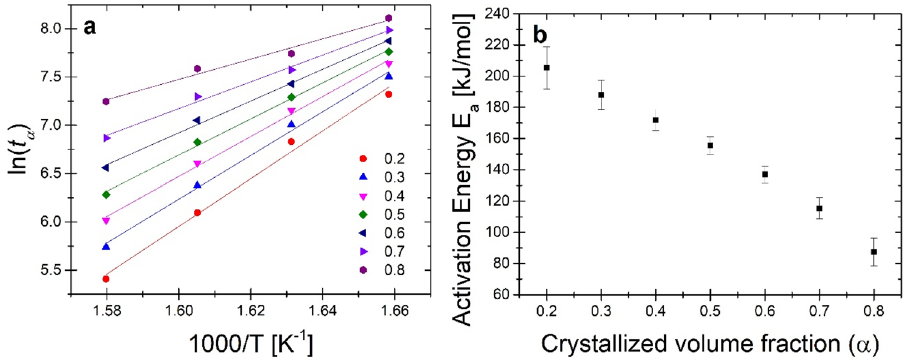
Figure 3. ( a ) Isothermal kinetics results: Arrhenius plots for activation energy determination; ( b ) local activation energy from crystallized volume fraction dependence.